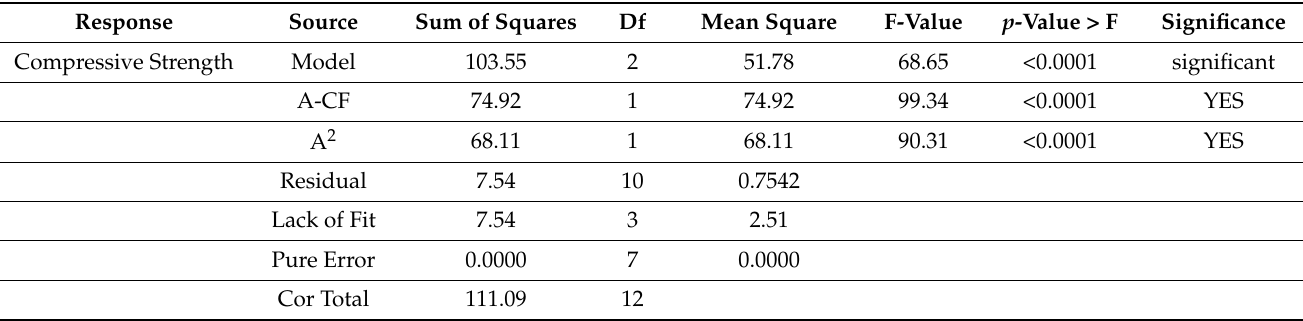
Table 6. ANOVA Results for the Variable Response 28-day Compressive Strength.